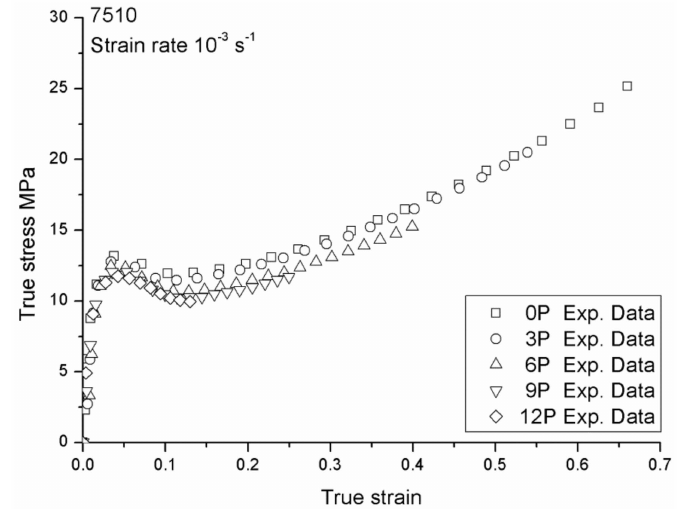
Figure 4. True stress vs. true strain responses of 7510 with di ff erent recycling numbers under a strain rate of 0.001 s − 1